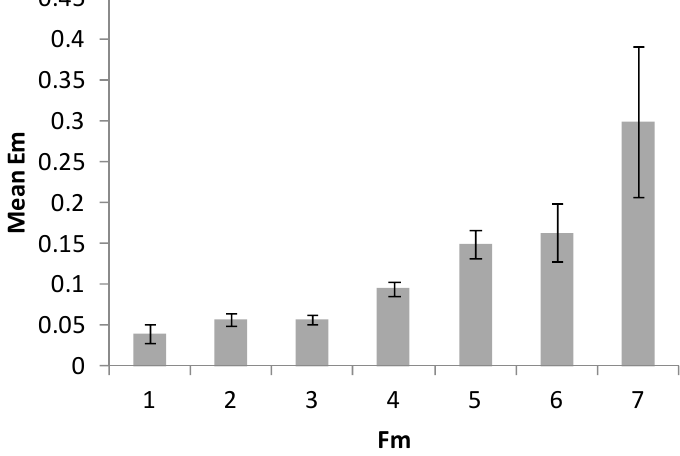
Figure 9. Mean error level per the number of information items, Moore neighborhood ( F M ).